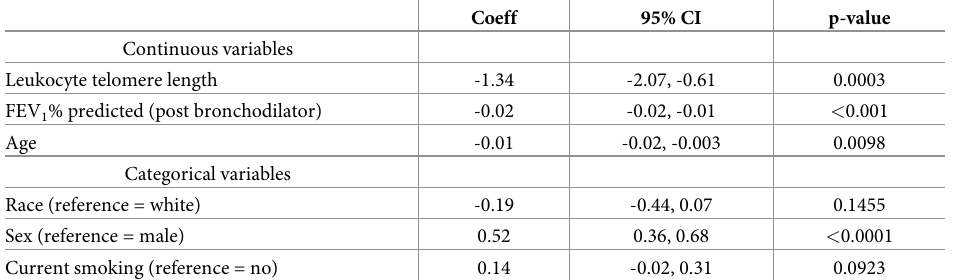
Poisson regression was constructed using leukocyte telomere length as the independent variable and number of all acute exacerbations (mild-moderate-severe) as the dependent variable, with covariates listed above. Follow-up time in years was included as the offset. Coeff = regression